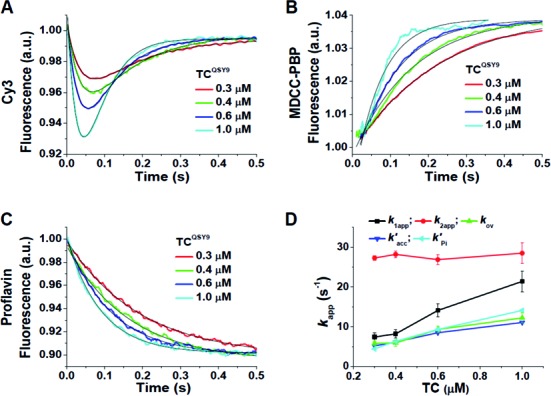
Ensemble studies of TCQSY9 reacting with 70SICCy3 (EF-Tu:L11 assay). (A)–(C) Changes of fluorescence on rapid mixing of 70SICCy3 (0.1 μM) with TCQSY9 as a function of TCQSY9 concentration. Lines through the traces are fit to Equation (1) (A) or Equation (2) (B) and (C). (A) Cy3 fluorescence. Experiments carried out either with 70SICCy3 containing fMet-tRNAfMet(prf) in the absence of C-PBP or with 70SICCy3 containing fMet-tRNAfMet in the presence of C-PBP gave very similar results. Results presented are the average of both experiments. (B) C-PBP fluorescence, carried out using fMet-tRNAfMet. (C) fMet-tRNAfMet(prf) fluorescence, carried out in the absence of C-PBP. (D) kapp values derived from measurements of changes in the fluorescence of the label shown in parentheses, as presented in parts (A)–(C): Cy3, k1app (black); Cy3, k2app (red); Cy3, kov (green); prf (blue), k’acc; C-PBP (cyan), k’Pi.